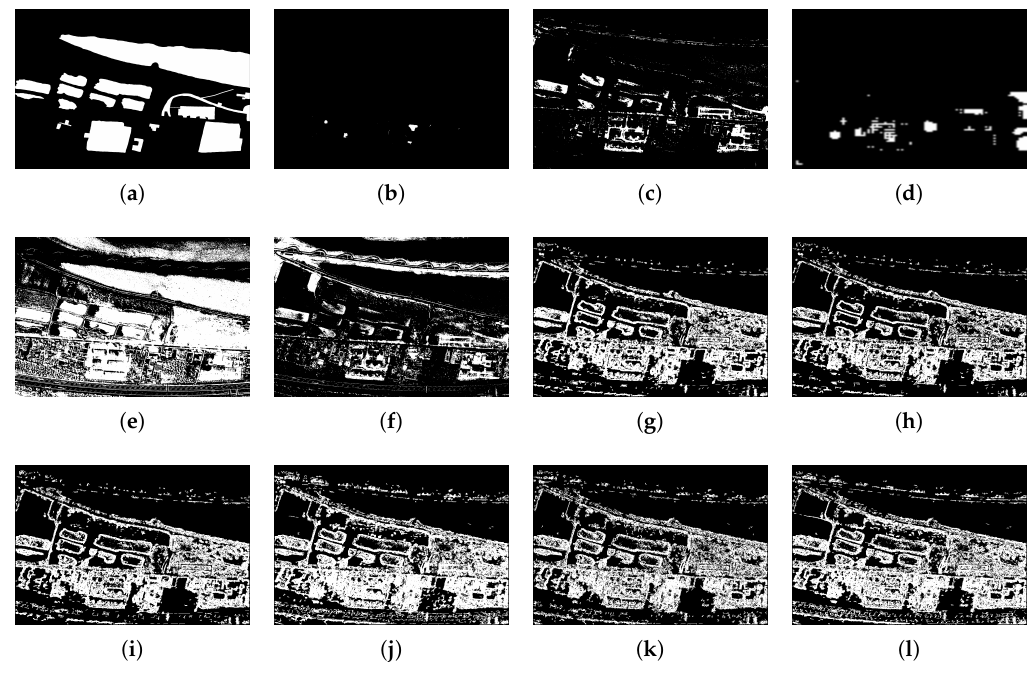
Figure 15. Change detection results of the Weihe Dataset. ( a ) Ground truth; ( b ) IR-MAD; ( c ) PCA-k-means; ( d ) CaffeNet; ( e ) USFA; ( f ) DSFA; ( g ) EM-SDAE: 100-50-20/with dropout; ( h ) EM-SDAE: 200-100-50-20/with dropout; ( i ) EM-SDAE: 500-200-100-50-20/with dropout;